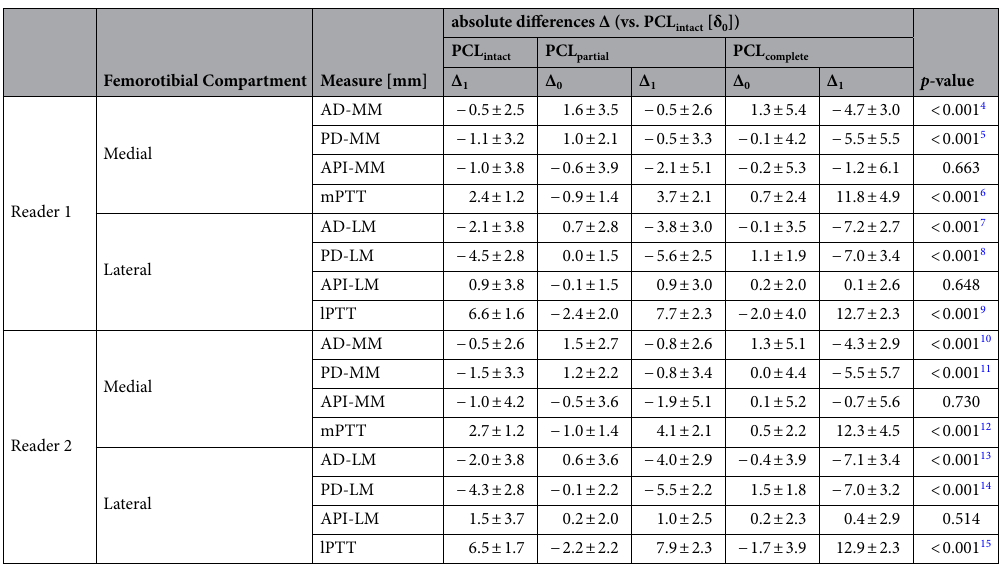
For the 3D computed vector measures (Table 1) and 2D manual reference measures (Table 2), absolute dif- ferences versus the unloaded PCL intact condition are detailed as a function of condition and configuration. The corresponding post-hoc test results are given in Supplementary Tables 1 and 2, while the absolute values of each measure are presented in Supplementary Table 3. Significant differences as a function of PCL condition and configuration were found for the 3D Euclidean vectors vector_FT (that connects the apex of the femoral trochlea [FT] and the centre of the tibial tuberosity [TT]) and vector_ASI (that connects the femoral [fASI] and tibial axis-surface-intersections [tASI]) as well as their projections on the x-, y-, and z-axis as detailed below (see Image Post-Processing to Quantify Joint Lax- ity ). Overall, significant differences were found primarily along the y-axis (anteroposterior dimension: y_ASI and y_FT [both p ≤ 0.001]), and along the x-axis (mediolateral dimension: x_FT [ p = 0.008]). In the following, findings of statistical significance refer to the post-hoc comparisons to the PCL intact condition. For the PCL intact condition, loading induced moderate changes in the joint with the largest and significant increases along the y-axis: Δ 1 [y_ASI] = 7.9 ± 3.2 mm; Δ 1 [y_FT] = 6.6 ± 2.4 mm. Corresponding vector lengths decreased under loading, yet non-significantly (Δ 1 [vector_ASI] = − 4.2 ± 5.2 mm [ p = 0.415]; Δ 1 [vector_ FT] = − 3.4 ± 2.8 mm [ p = 0.101]). In partially PCL-deficient joints, loading-induced changes in the joint were ambiguous and variable for vec- tor lengths and their projections on the x-, y-, and z-axes. Along the y-axis, increases were moderate, yet not significant for y_ASI (Δ 1 [y_ASI] = 9.8 ± 5.8 mm [ns]) or y_FT (Δ 1 [y_FT] = 4.4 ± 5.7 mm [ns]). In completely PCL-deficient joints, loading induced even larger and partially significant changes in the joint, with the largest increases found along the y-axis (Δ 1 [y_ASI] = 15.2 ± 5.1 mm [ *** ]; Δ 1 [y_FT] = 12.0 ± 5.0 mm [ns]). Mean vector lengths were not homogenously altered under loading. For y_ASI and y_FT, numerous significant differences were noted between the δ 0 - and δ 1 -configurations of the various PCL conditions, while for other 3D computed vector measures, no significant loading-induced differences were found (Table 1 and Supplementary Table 1). Overall, the 2D manual reference measurements validated the 3D computed vector measurements (Table 2). The largest mean increases were found for lPTT (lateral PTT) under loading, e.g., reader 1 [δ 1 ,], PCL intact : 6.6 ± 1.6 mm; PCL